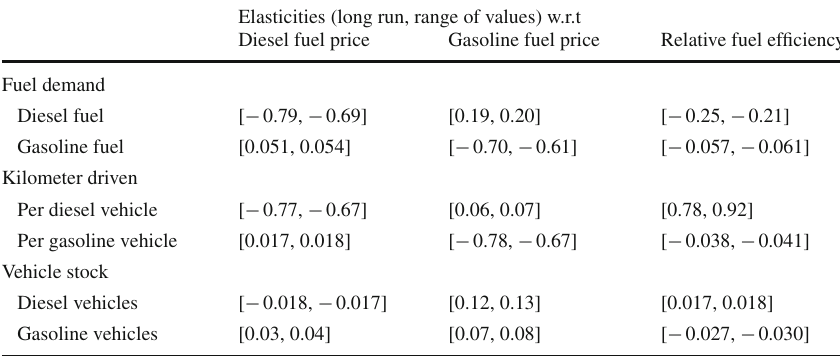
Table 4 Implied elasticities of various measures of demand Elasticities (long run, range of values) w.r.t Diesel fuel price Gasoline fuel price Relative fuel